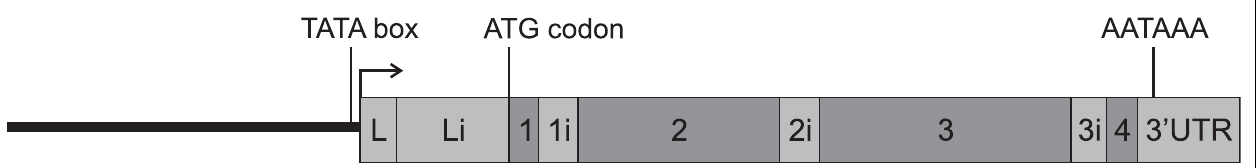
intron, respectively. Numbers 1–4 are exons and numbers 1i–3i are introns. Transcription start and translation start are indicated by an arrow and ATG, respectively, and AATAAA is a polyadenylation